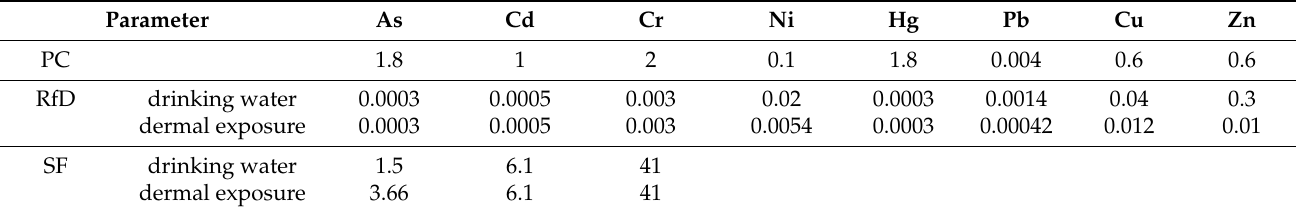
Table 4. Groundwater parameter values of PC, SF, and